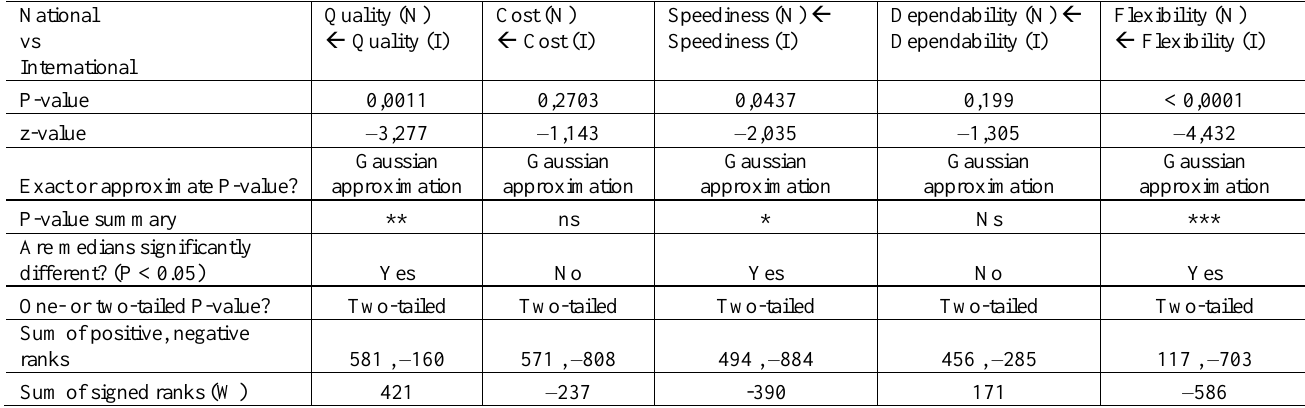
Table 5: Wilcoxon matched-pairs signed ranks rests: movement between decision points : Current strength and/or weakness National vs